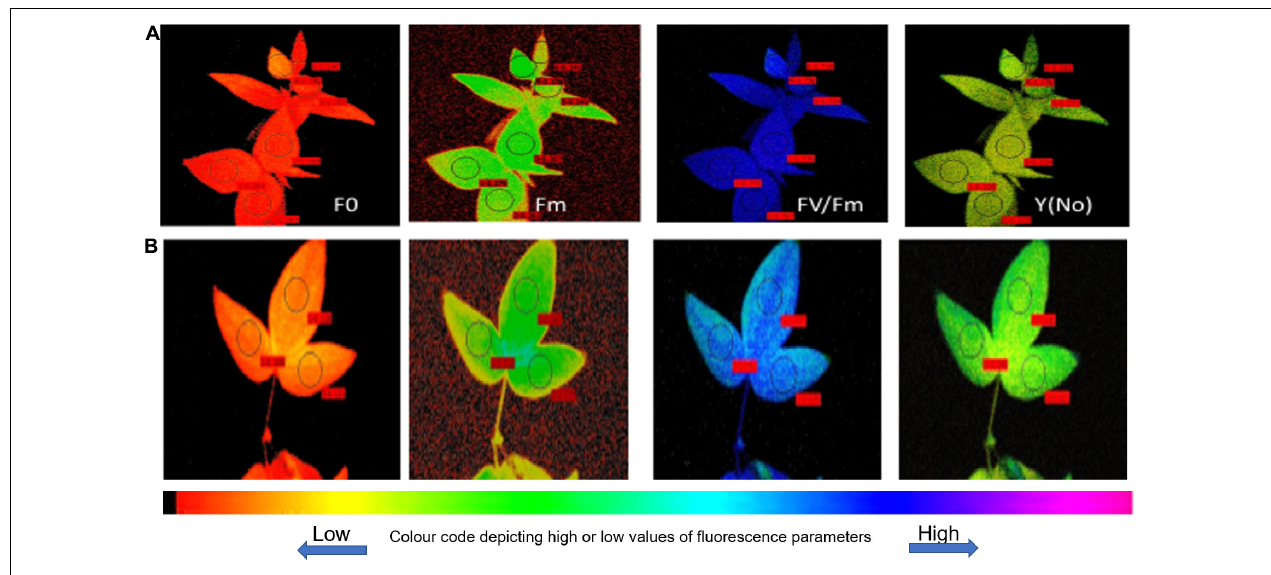
FIGURE 4 | Fluorescence images for heat-tolerant (A) (UPU85-86) and heat-sensitive genotypes (B) (PKGU-1).